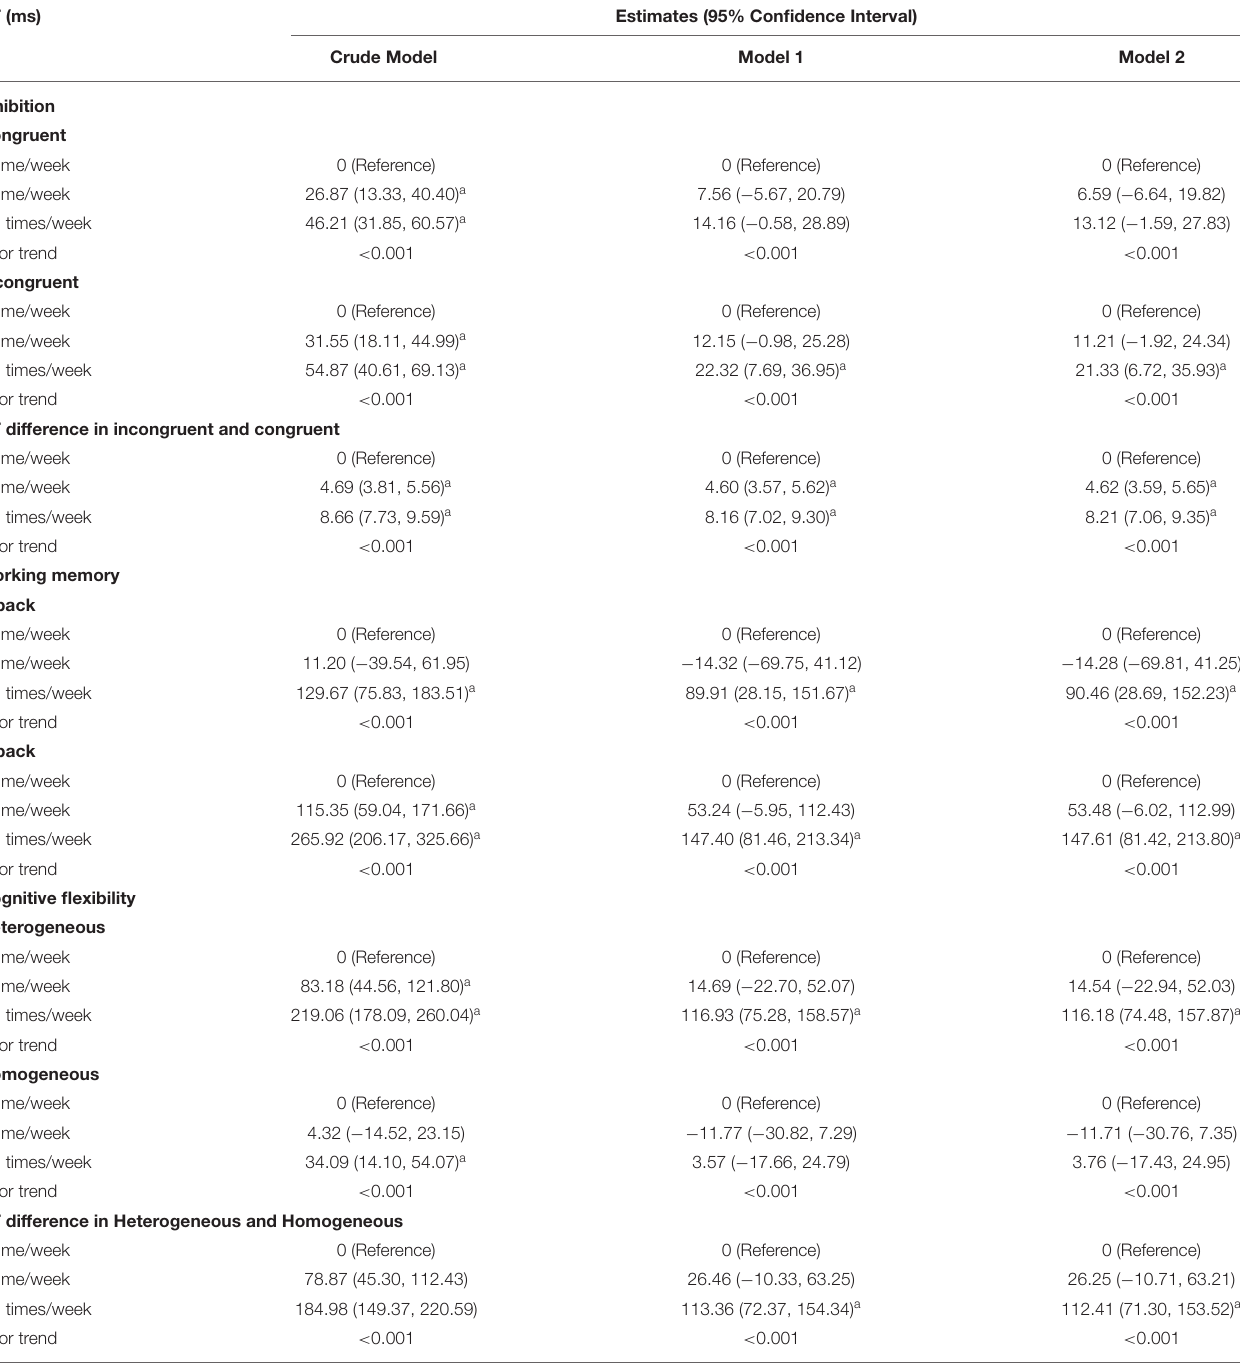
TABLE 3 | The multiple linear regression of executive function for Chinese Tibetan adolescents with different SSB consumption ( n =